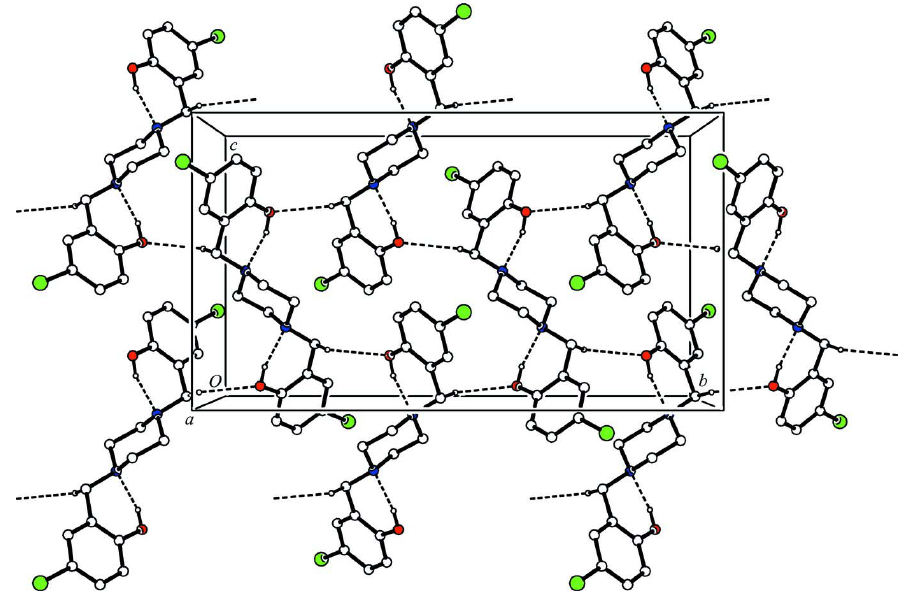
The molecular packing of (I), showing the formation of a sheet with a first level graph set S (6) C (5) R 66 (26). The hydrogen bonds are shown as dashed lines. The H atoms not involved in the hydrogen bonds have been omitted for